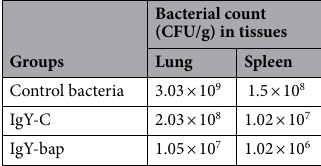
Table 1. The number of bacteria per gram of spleen and lung tissue 16 h after challenge in each mice group.